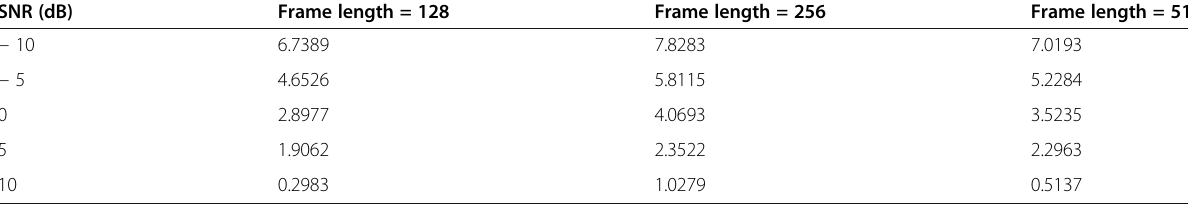
Table 2 Increment of SNR in the white noise environment with different frame lengths (dB) SNR